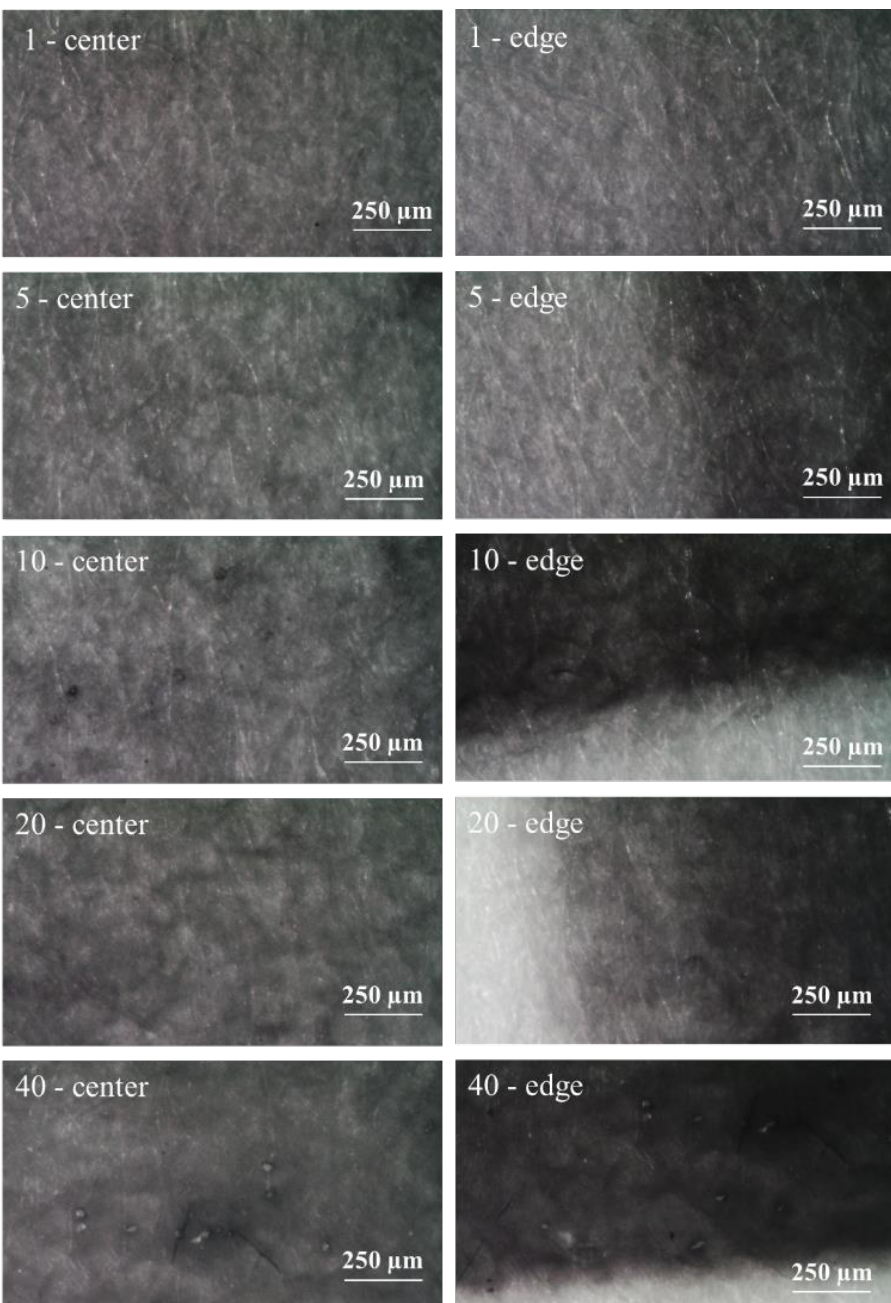
Figure 17. Optical microscope images of inkjet-printed MWCNT films on photo paper at 50 μm drop spacing and varying layer counts (1–40 as labeled in each panel), showing both center and edge regions of films.